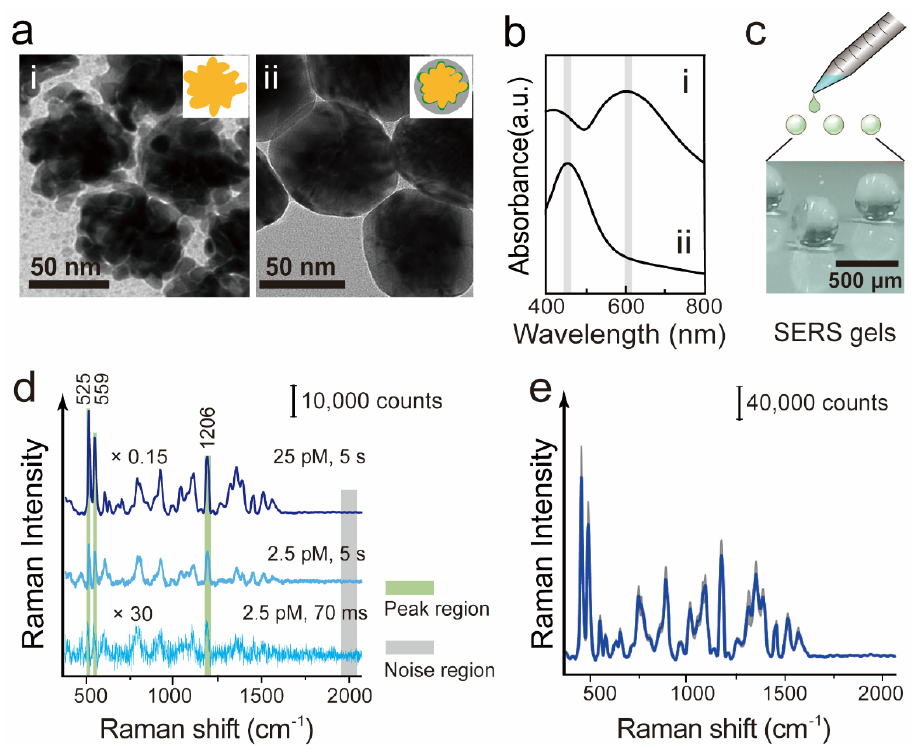
Figure 4. The procedures for SERS gel preparation and Raman measurements. ( a ) TEM images and ( b ) extinction spectra for ( i ) petal-like Au cores and ( ii ) Ag-shell-coated SERS NPs. ( c ) The preparation of SERS gels. ( d ) Raman spectra of SERS gels containing 25 or 2.5 pM NPs. Raman peaks of the gels (525, 559, 1206 cm − 1 ) are marked in green, and the region for noise deviation calculation (1950–2050 cm − 1 ) is marked in grey. The excitation power was 20 mW. ( e ) Measurements on three SERS gels containing 25 pM NPs. The measurements were repeated 30 times. The data were plotted using averages and the shadows for standard deviations.